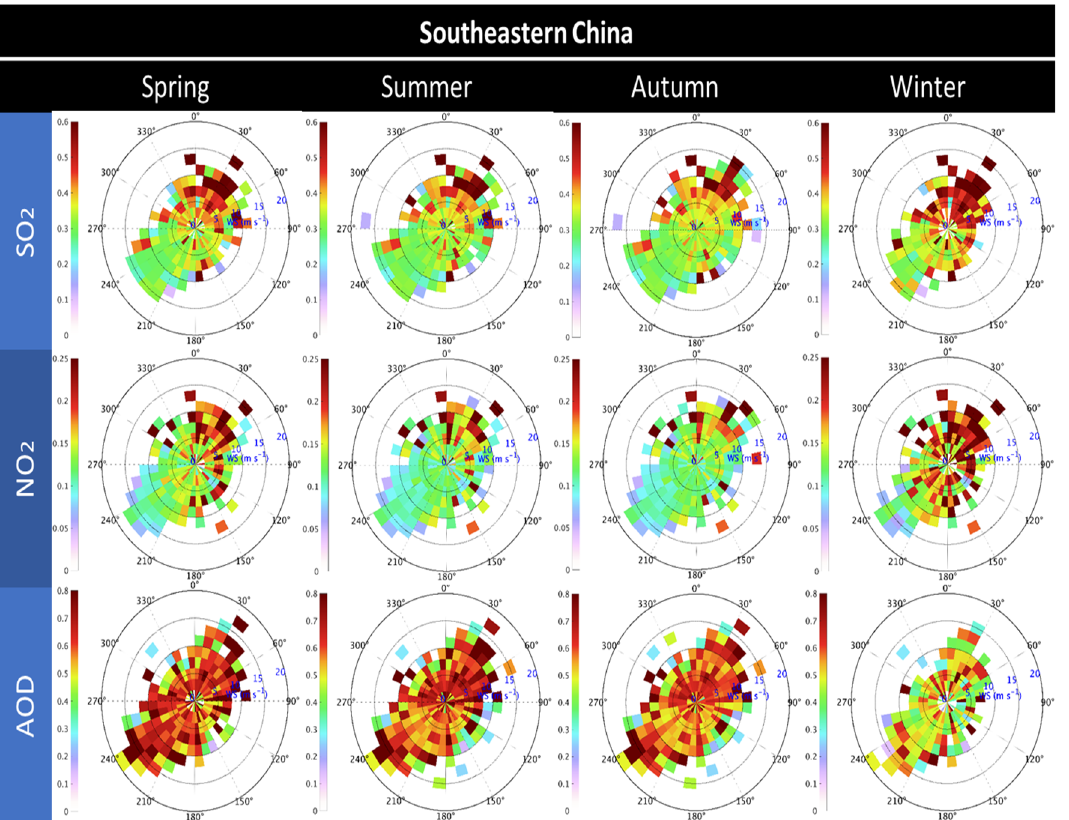
Figure 9. Summary of wind dependency of SO 2 , NO 2 , and AOD in Southeastern China for each season. The shading color indicates the value of SO 2 , NO 2 , and AOD. The radial direction and radial distance represent the wind direction and wind speed at 850 mb, respectively.